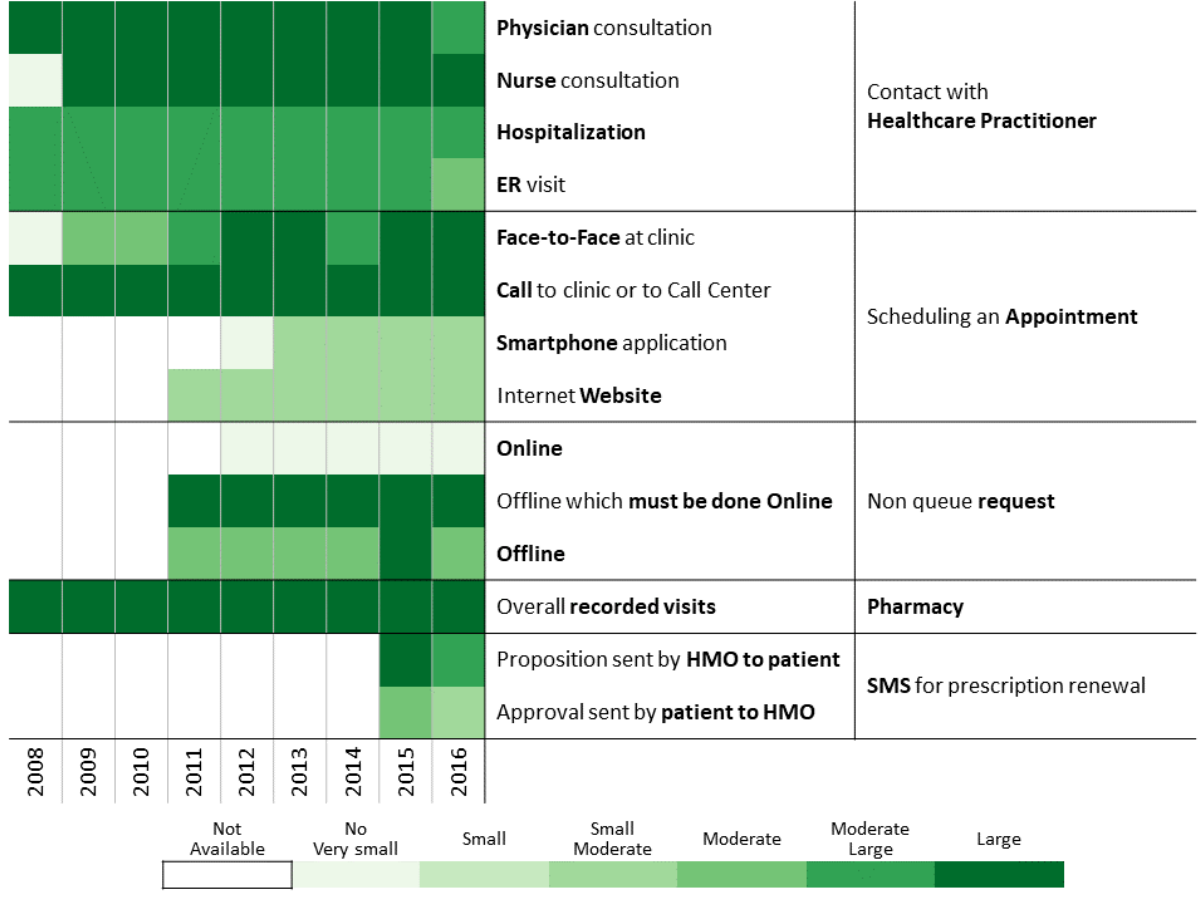
Figure 16. Communication pattern changes between 2008 and 2016 for patients with diabetes having mainly human-based contacts based on interactions with